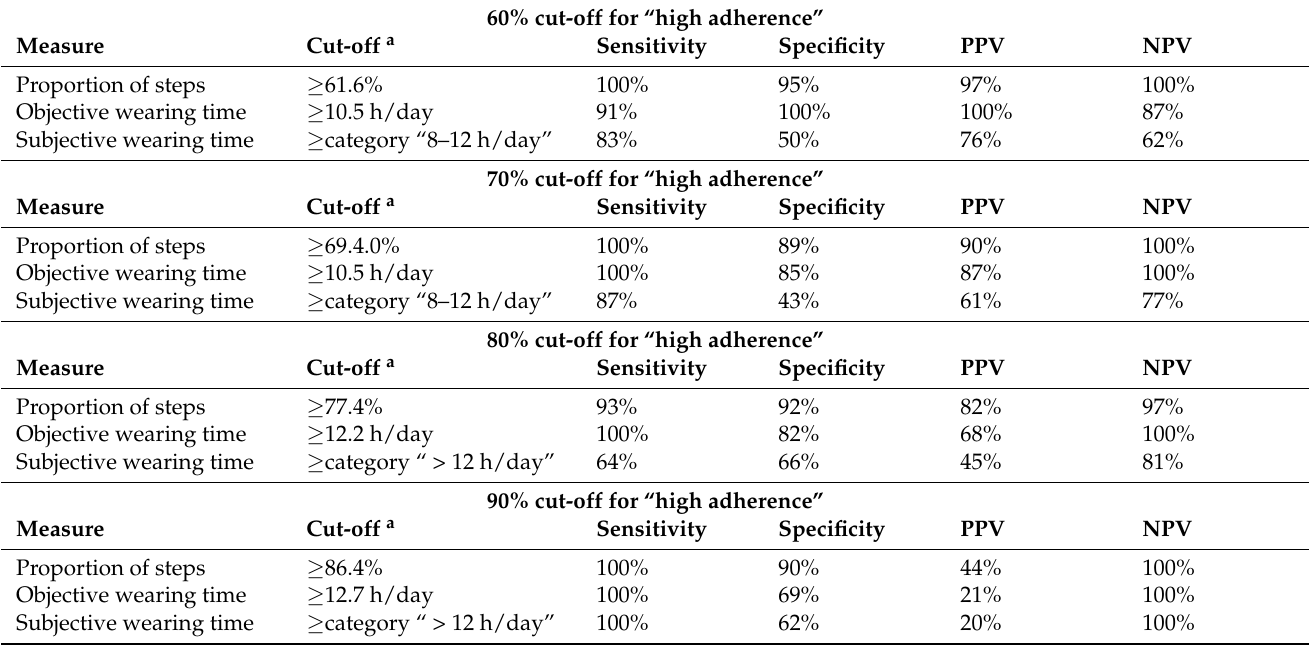
Table 3. Sensitivity, specificity, positive predictive value (PPV), and negative predictive value (NPV) for different cut-offs for “high adherence” according to the reference